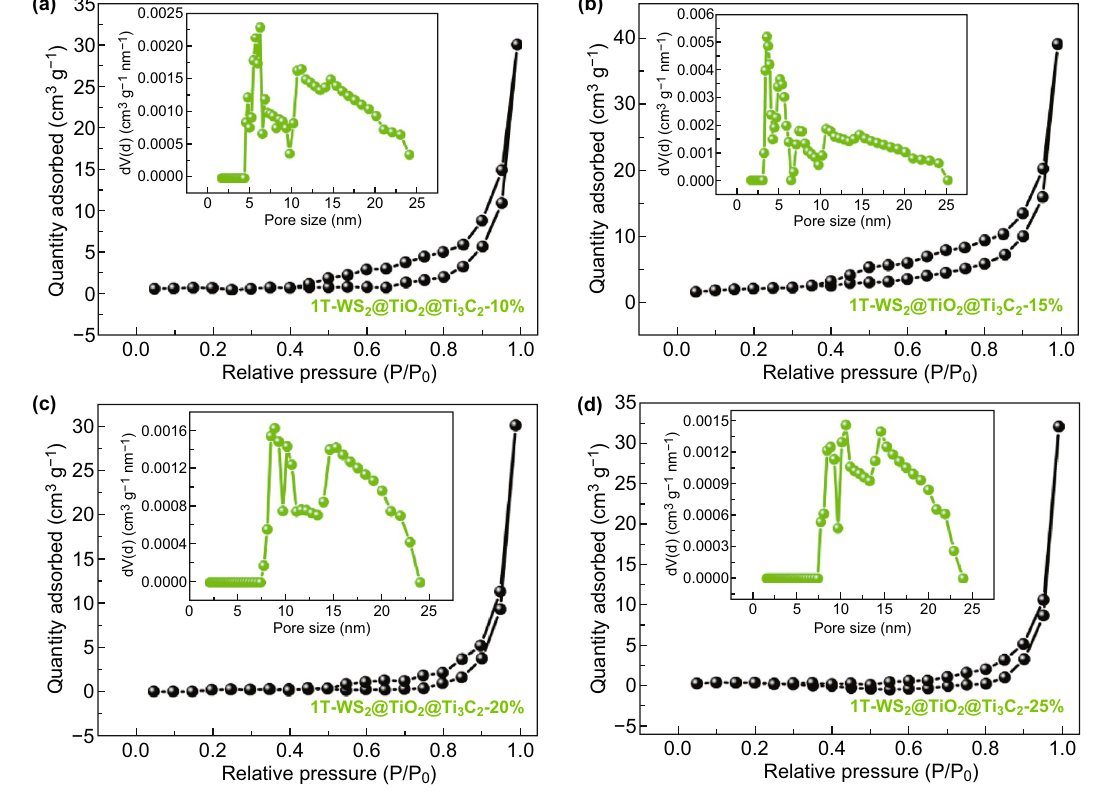
Fig. 4 N 2 adsorption–desorption isotherms and corresponding pore size distribution curves (inset) of 1T-WS 2 @TiO 2 @Ti 3 C 2 composites with a 10 wt%, b 15 wt%, c 20 wt%, and d 25 wt% WS 2